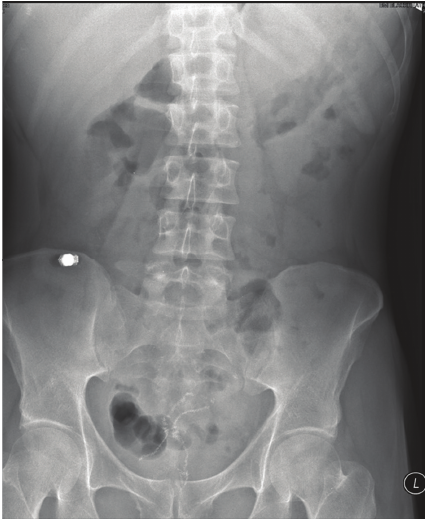
Figure 1: Plain abdominal X-ray showing retained capsule.